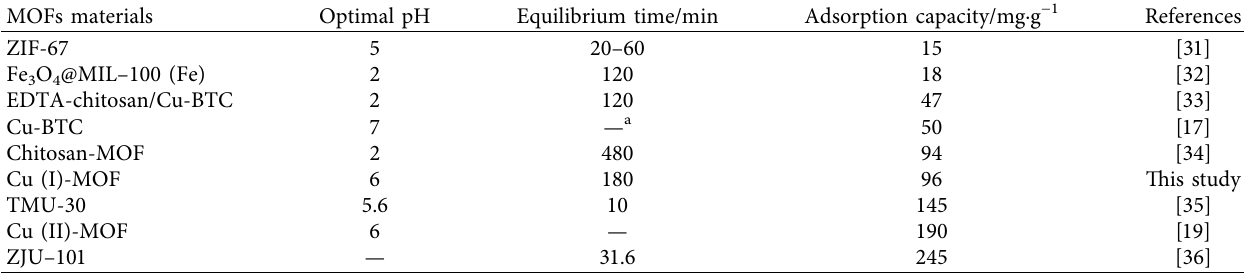
Table 3: Comparison of adsorption performance parameters of Cr (VI)with other MOF materials in aqueous